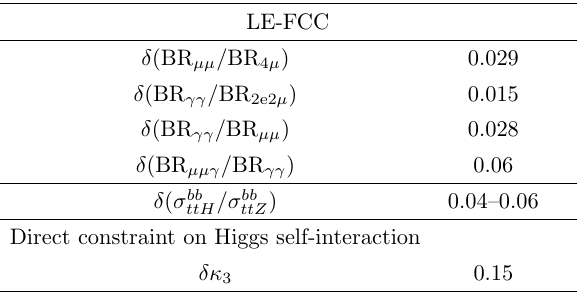
Table 26 . Inputs used for a low-energy FCC-hh running at 37.5 TeV (LE-FCC). All uncertainties are given as fractional 68% CL intervals and are taken to be